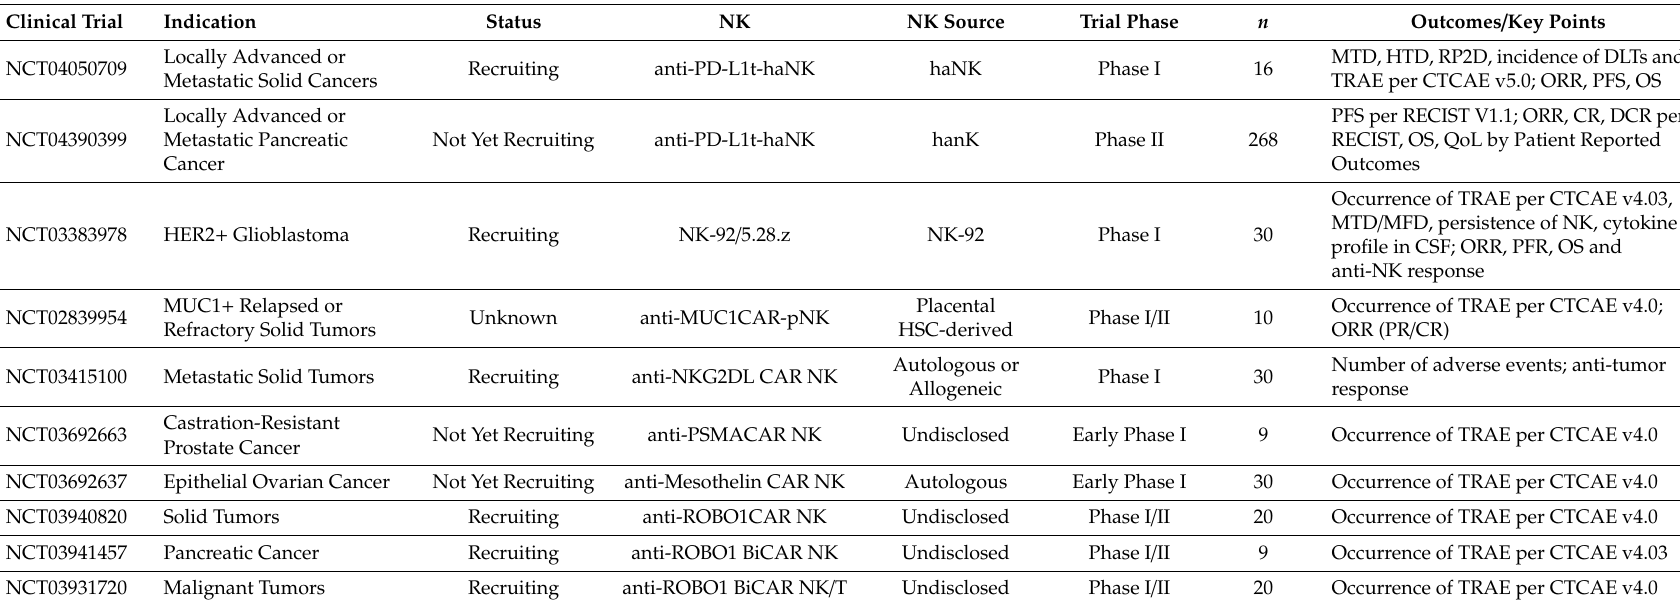
Table 2. Clinical trials in Solid Tumors using CAR-NK